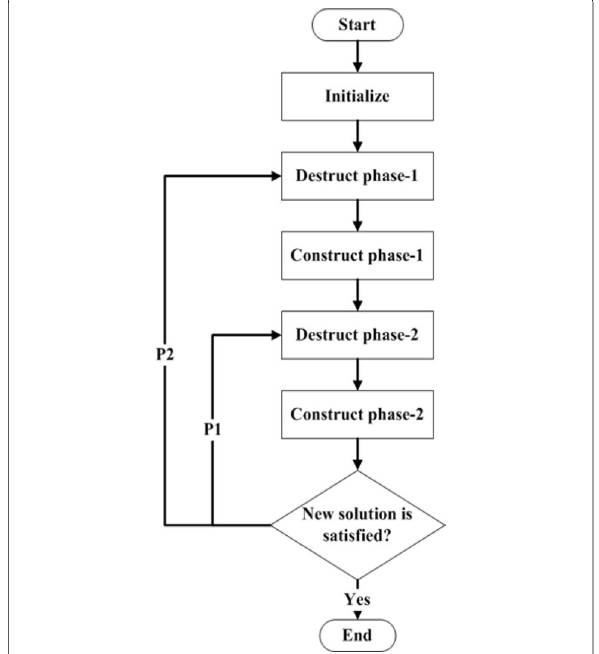
Figure 1 Flowchart of the MIG